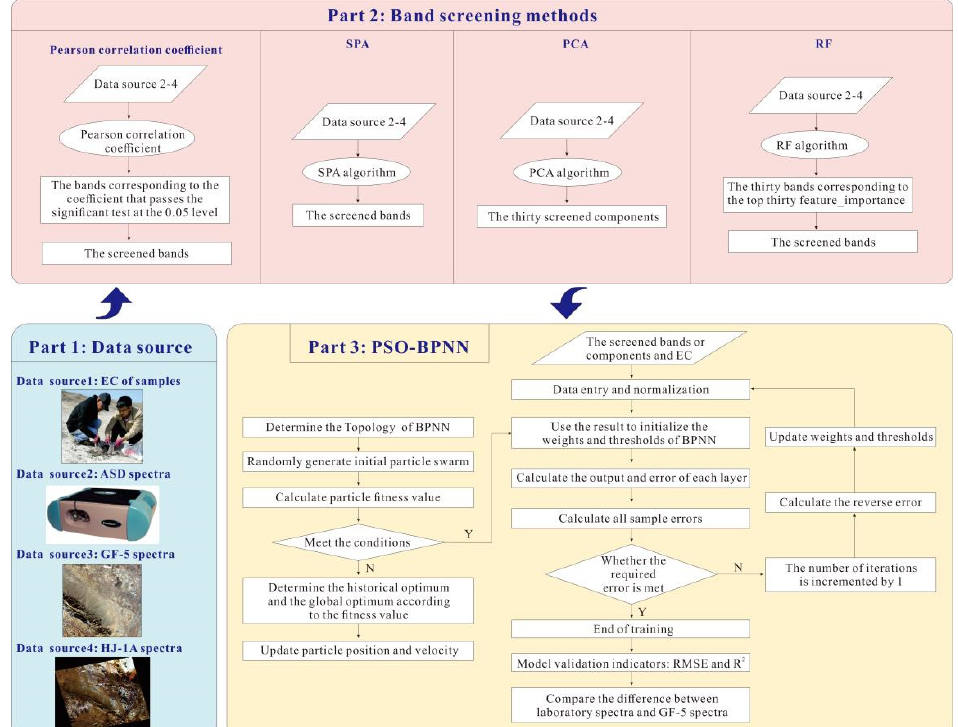
Figure 4. Technical flow chart of this research.